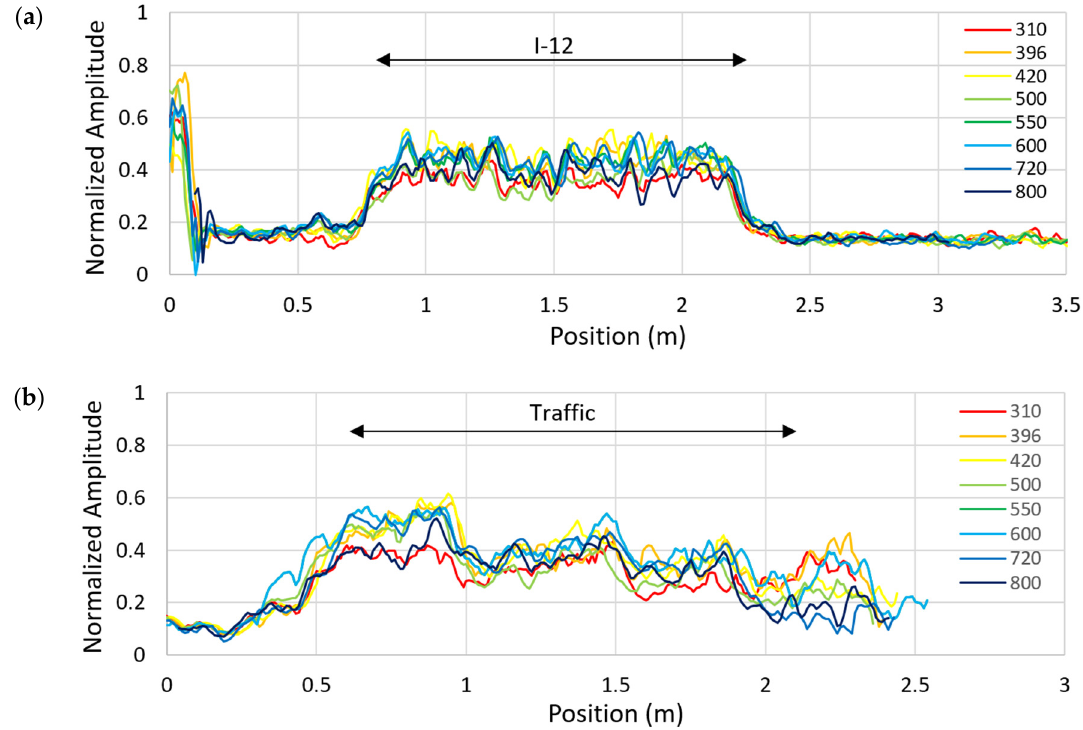
Figure 17. 1.5 GHz Norm. RW amplitudes on geotextile (I-12) in the ( a ) long. and ( b ) transv. direction vs. K loadings.